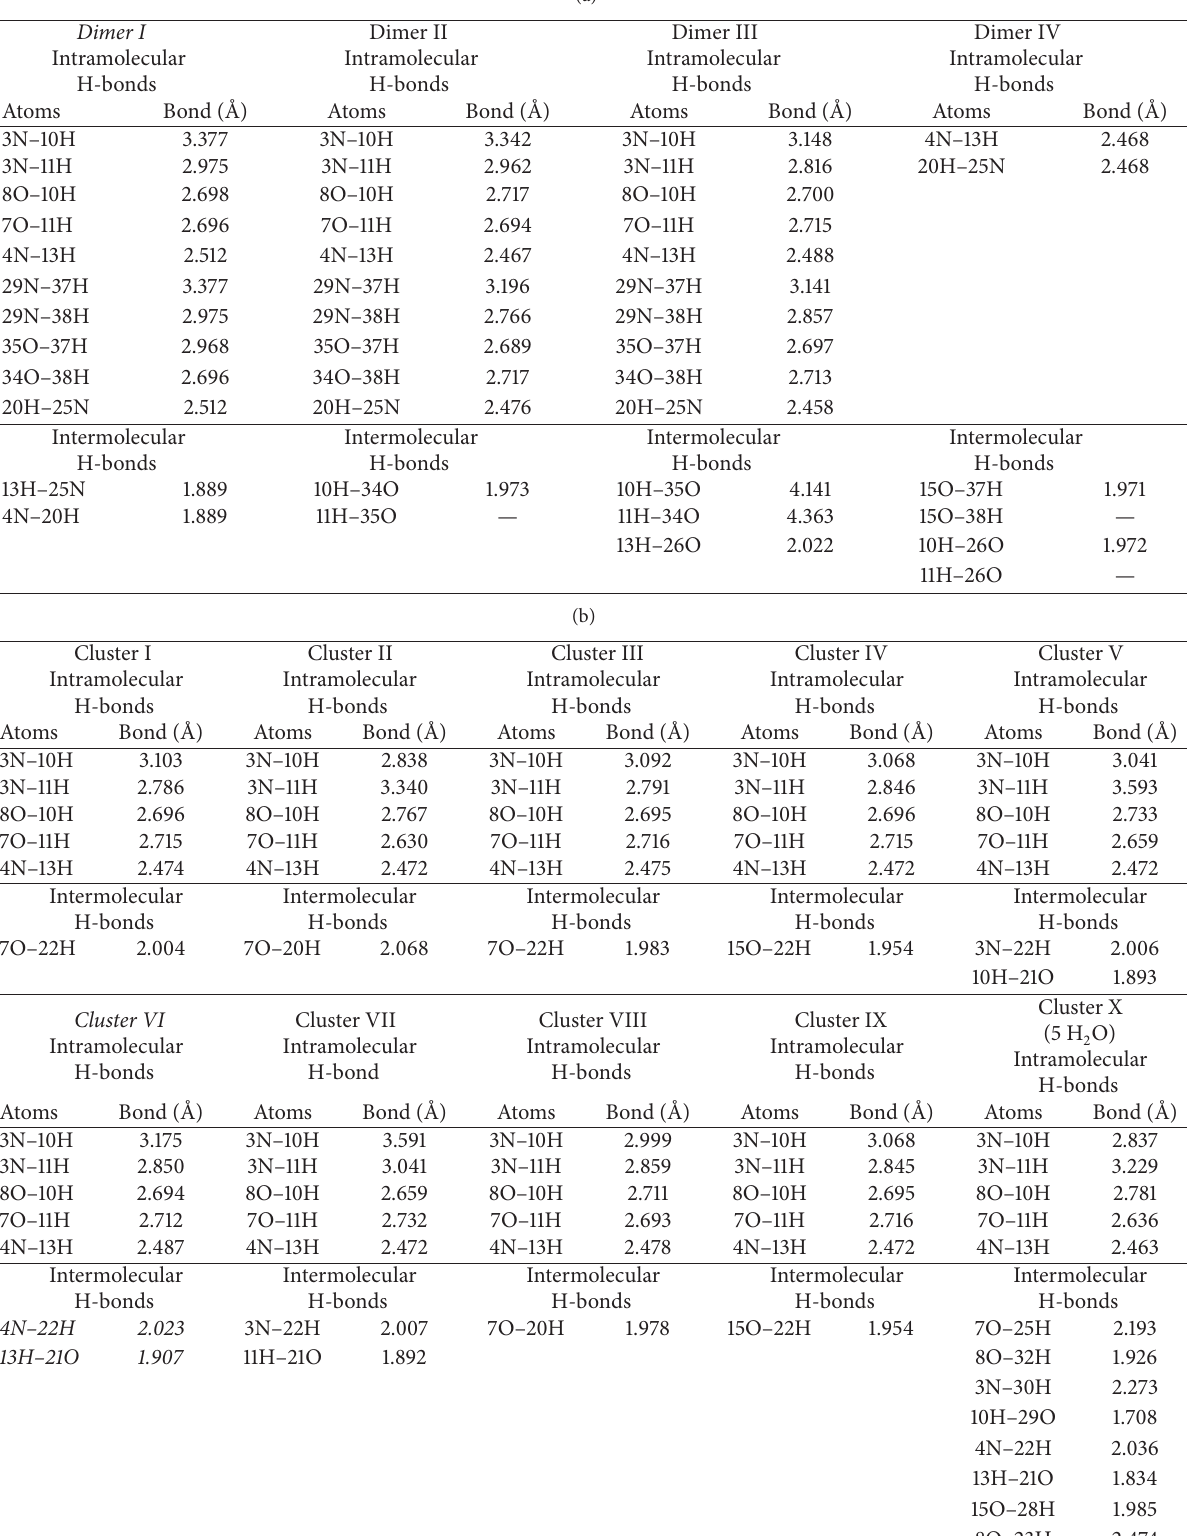
O clusters (I–X) of 2